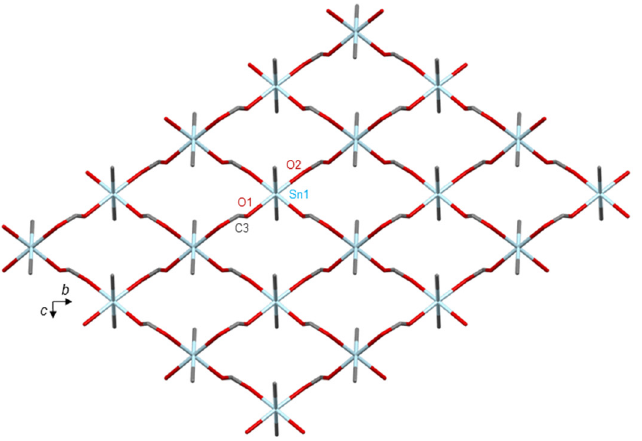
Figure 7. Infinite sheets based-structure of [Me 2 Sn(O 2 CH) 2 ] n (CCDC ref.: SIFLEY, 1258788), adapted from [59] (MERCURY view). Hydrogen atoms are omitted for clarity (Sn light blue, O red, C grey).